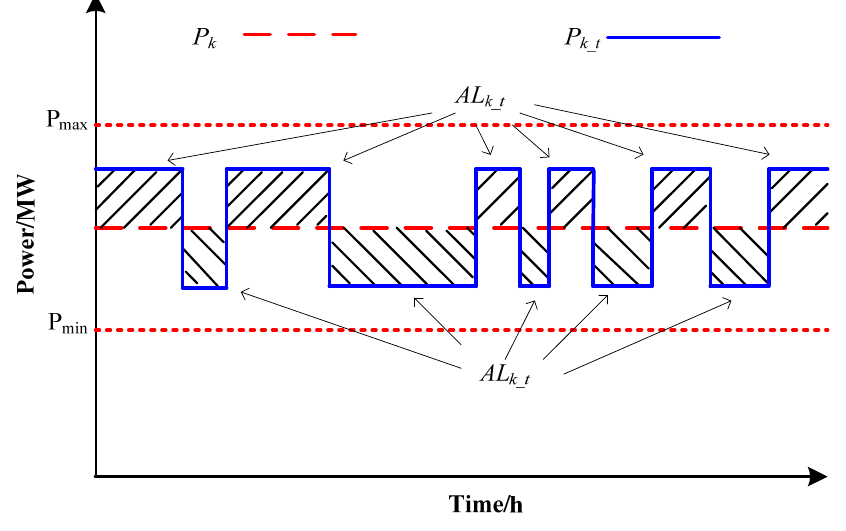
Figure 5. The load curve of aluminum smelter k